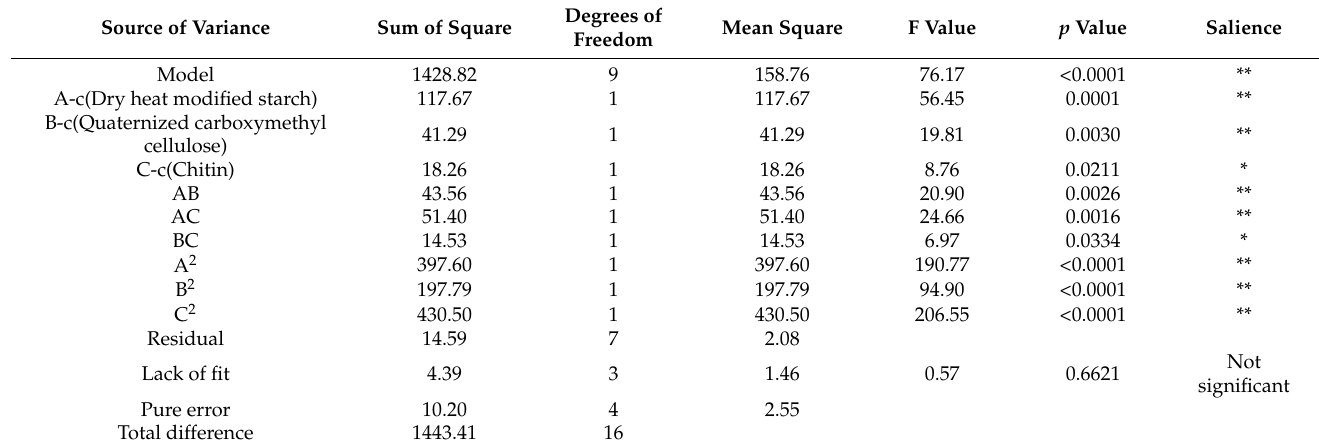
Table 3. ANOVA of the test results for the hydrogel compression performance.